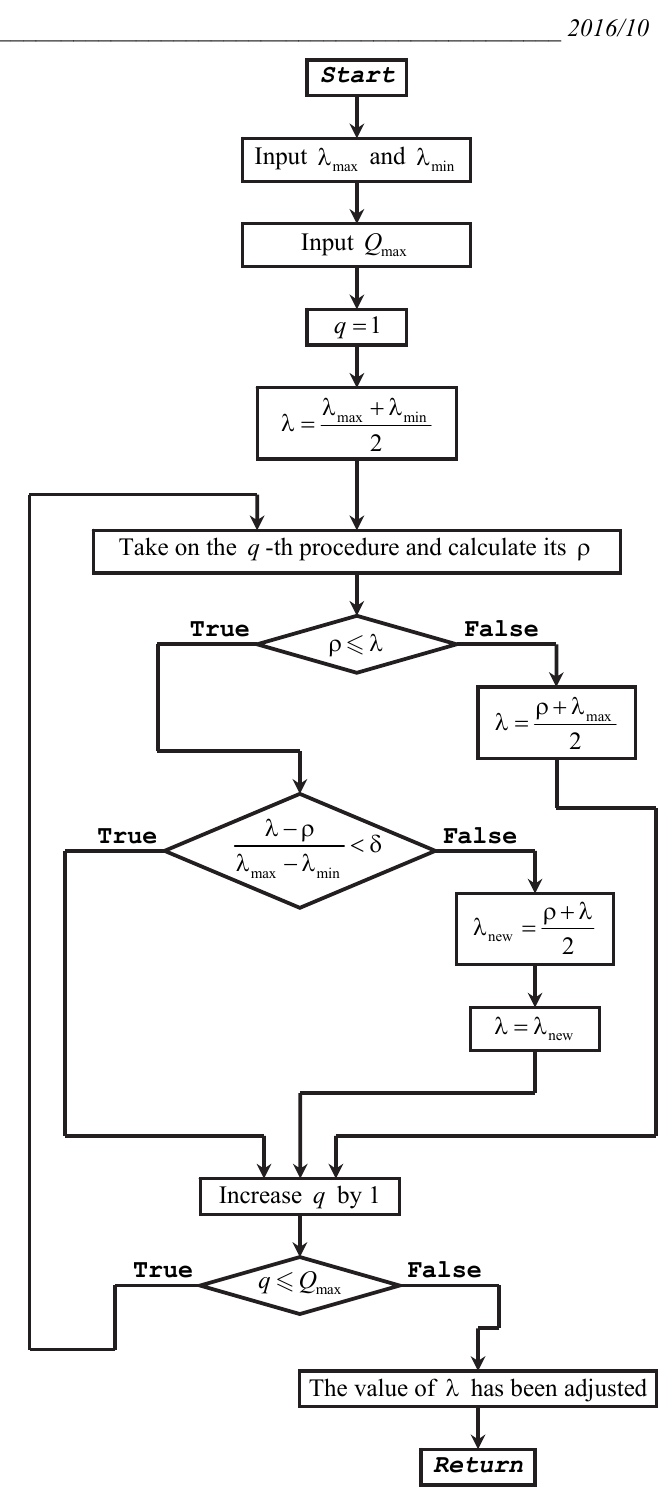
Fig. 1. An algorithm of hard adjusting. At the start, three algorithm parameters Q . Tolerance  are input: real numbers  ,  , and positive integer min max max allowing the closeness of  to  to be controlled is set beforehand. Note that inequality (5), which is used to control the closeness, may turn true for a long sequence of expert procedures what is presumed to say that  is stable enough and the adjusting is expected to be stopped. Neither the way of  calculation, nor tolerance  is specified here. Once the maximal number of Q is passed, the value of  is treated to have been expert procedures max adjusted owing to the law of large